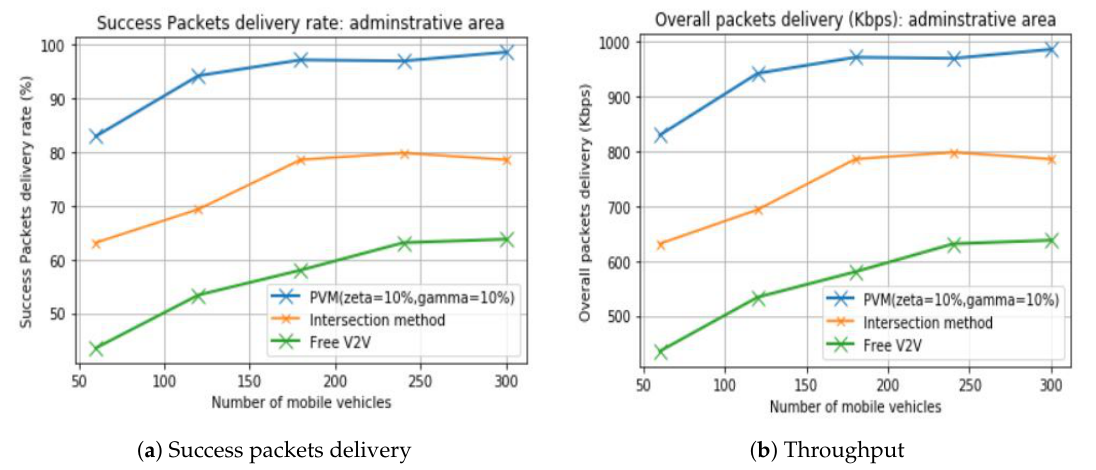
Figure 23. Overall packets delivery & Throughput: Administrative area.